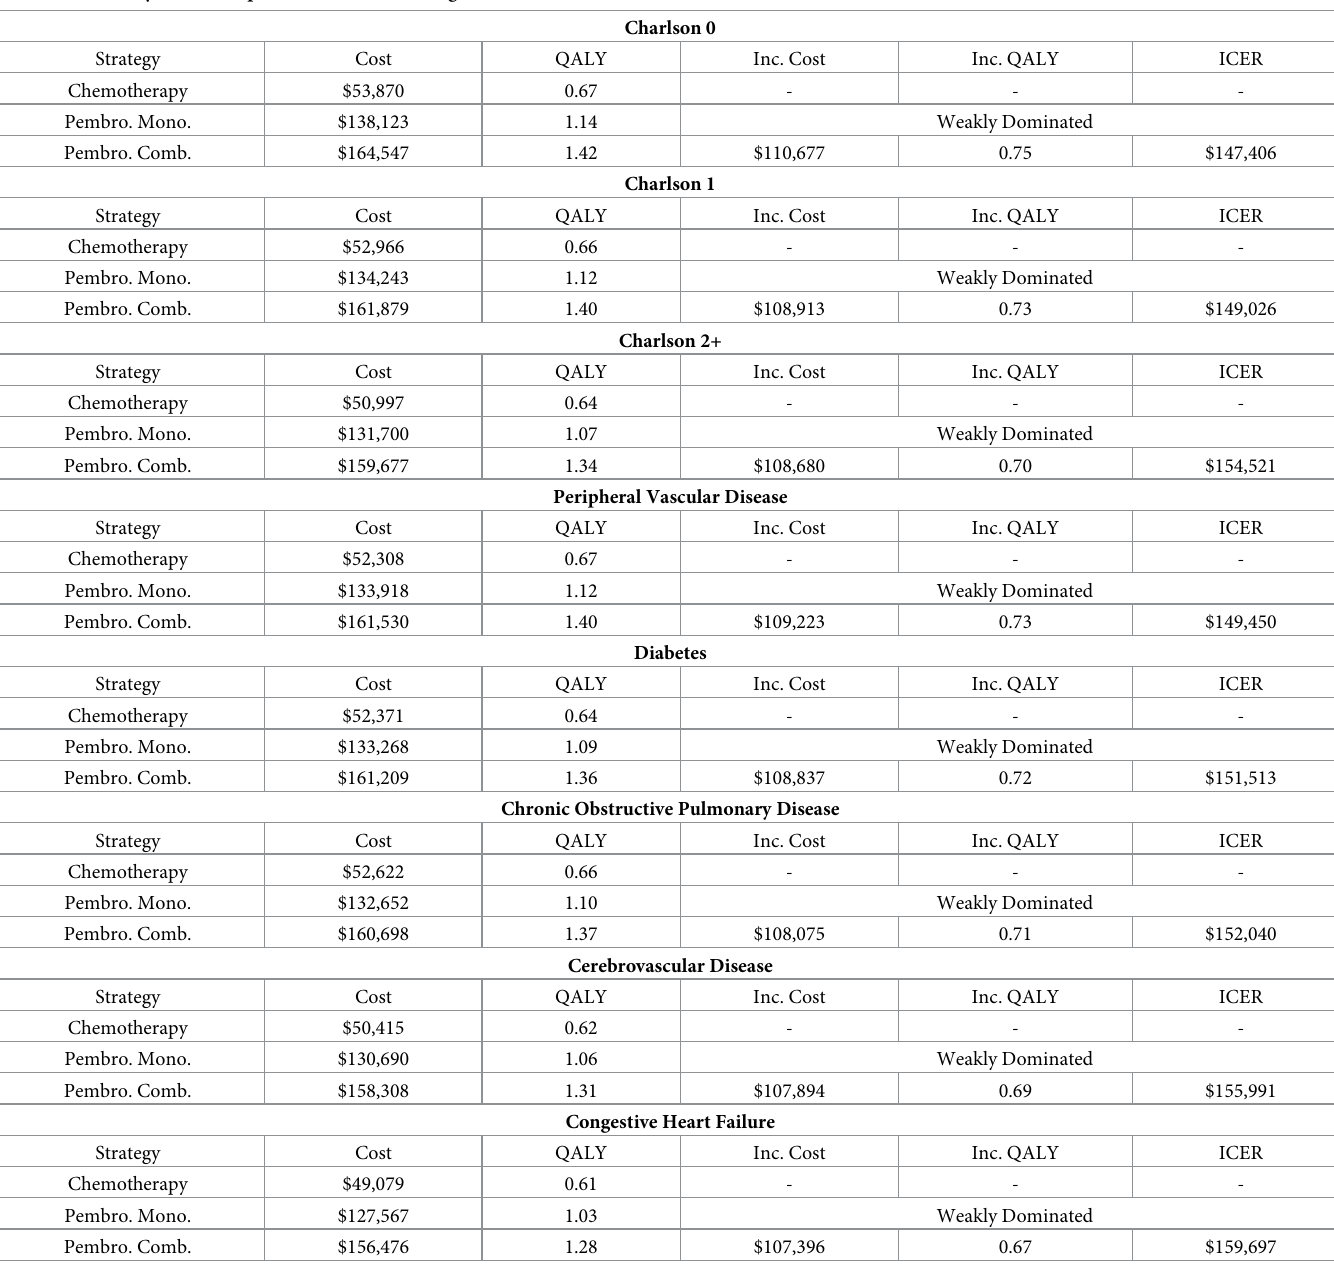
Table 3. Summary results for patients in the PD-L1-high model.